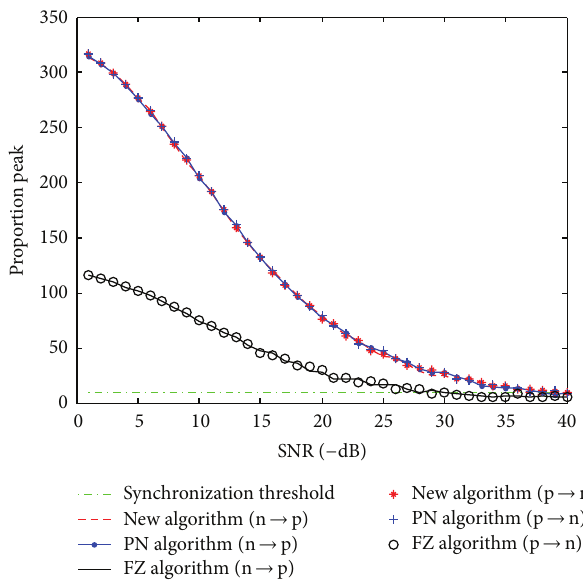
Figure 9: The proportion peak comparison with changing SNR.